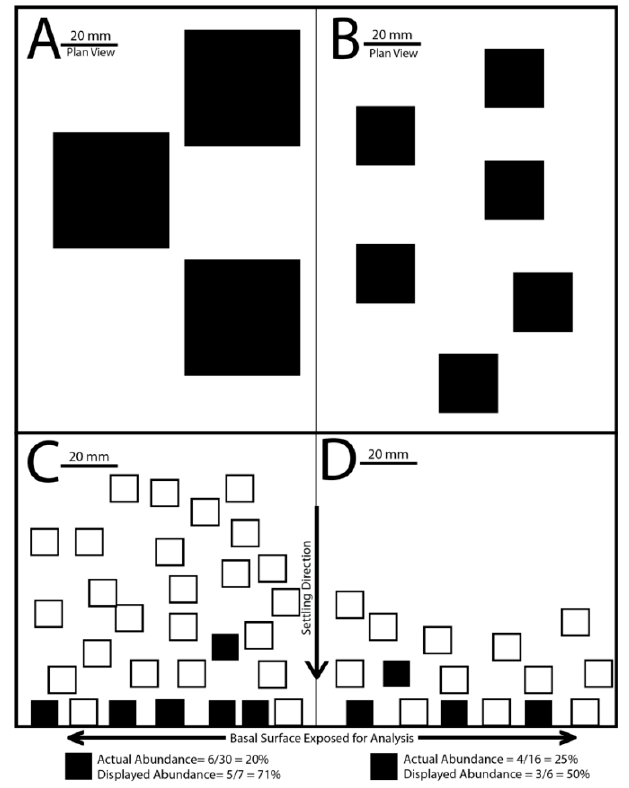
Figure 5. A,B conceptual view of the basal surface of epoxy grain mounts: ( A ) three large heavy (black) mineral grains; ( B ) six small heavy (black) mineral grains. The area (%) values for heavy grains on mounts A and B are identical even though mount A contains half as many grains as mount B. C,D conceptual cross section view through epoxy grain mounts: ( C ) grain mount containing a greater total number of grains (30) than mount D, with four black grains out of a total of seven grains exposed on the basal surface; ( D ) grain mount containing a smaller total number of grains (16) than mount C with three black grains out of a total of six grains exposed on the basal surface The actual abundance of heavy (black) grains per total grains mounted in epoxy is lower in mount C (5 out of 30 grains) than in mount D, but due to the preferential settling of heavier minerals through the curing epoxy, the displayed abundance on the polished basal surface is higher in mount C (71%) than D (50%).